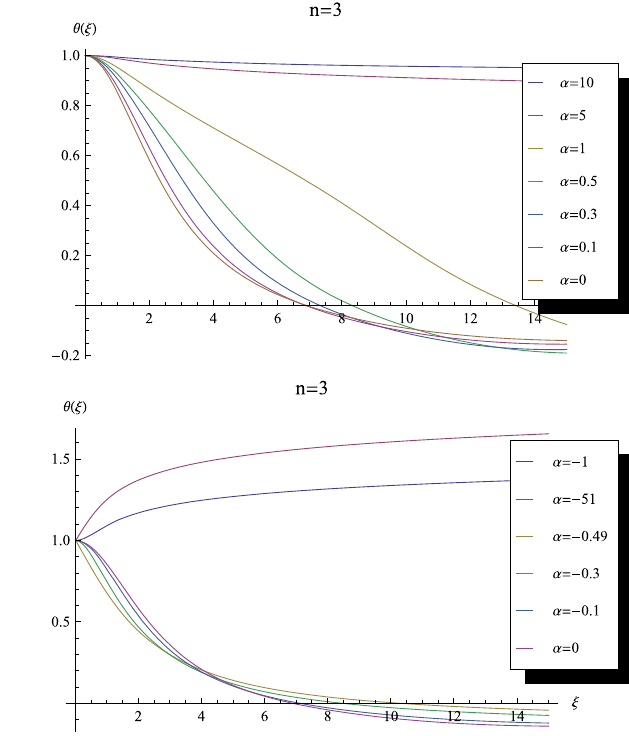
Fig. 3 Plots of the numerical solutions for the case n = 3 for positive (top) and negative (bottom) values of the parameter α